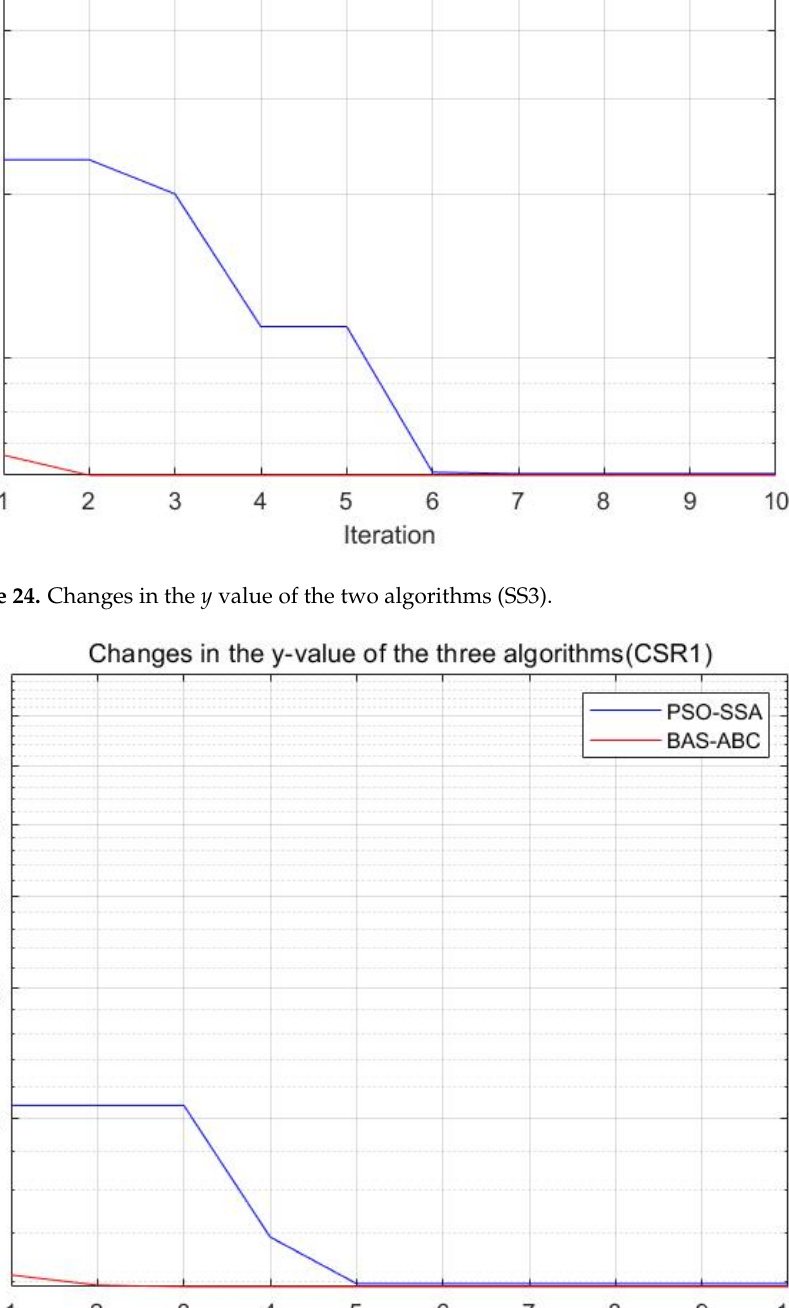
Figure 25. Changes in the 𝑦 value of the two algorithms (CSR1).